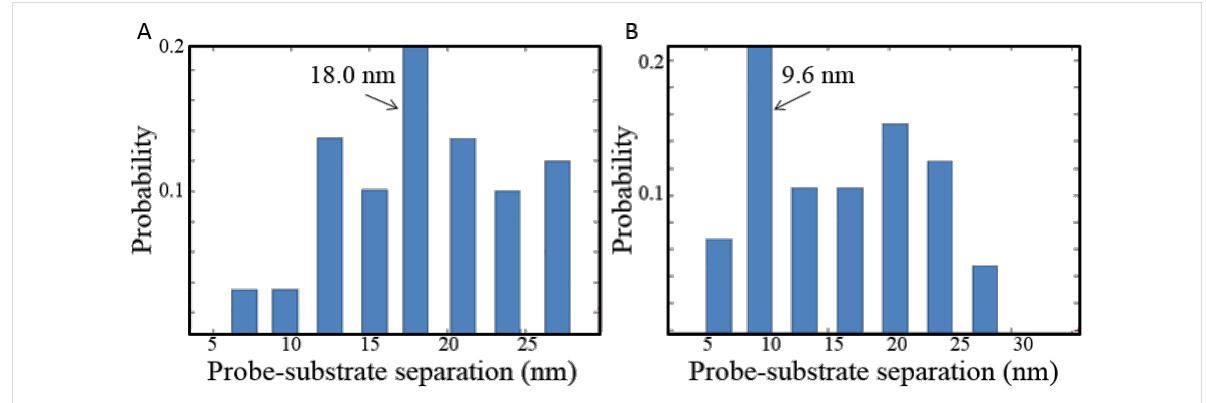
Figure 5: Distribution of probe-substrate separation where maximum adhesion force (bond rupture event) was recorded. (A) The distribution for the Si probe and (B) the distribution for the Au-coated probes.